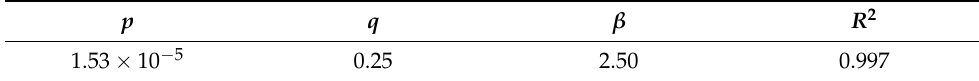
Table 1. Improved Generalised Bass Model Coefficient Estimation